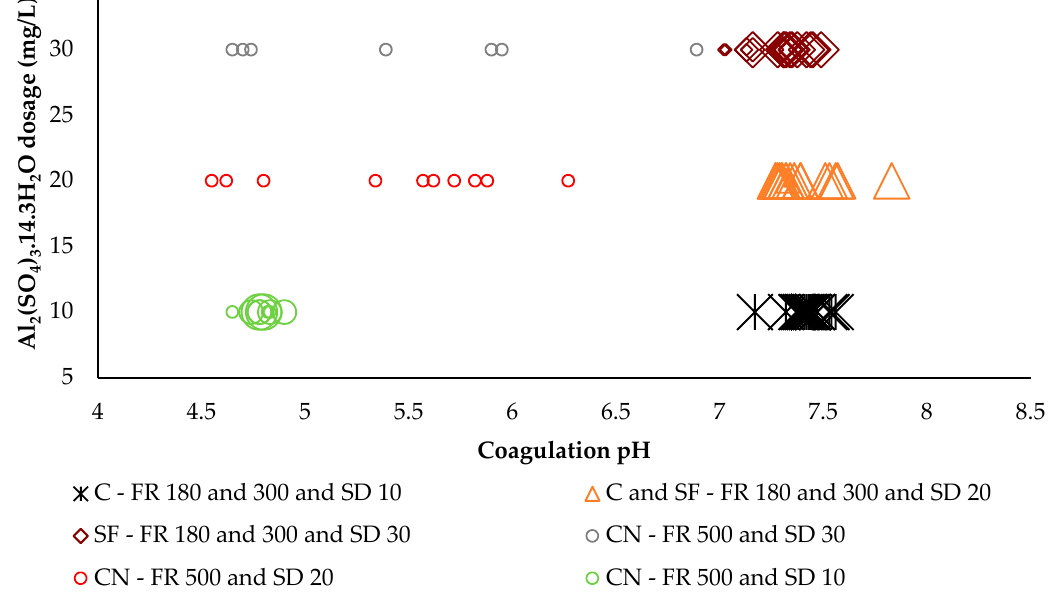
Figure 8. Coagulation diagram with remaining turbidity points for coagulation pH levels and aluminium sulfate dosage—pilot Water Treatment Plant. Smaller symbols: remaining turbidity > 0.5 NTU, intermediate size symbols: remaining turbidity between 0.25 NTU and 0.5 NTU and larger symbols: remaining turbidity < 0.25 NTU.